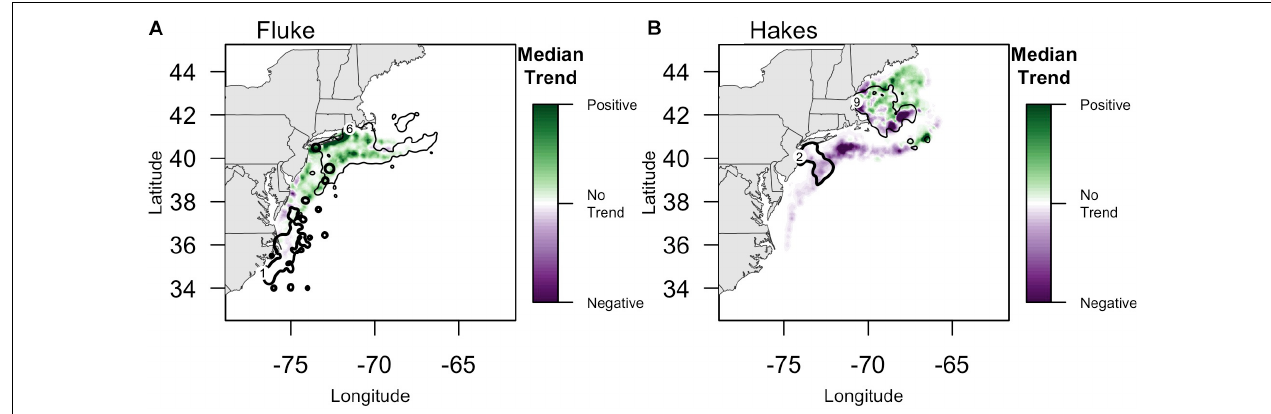
FIGURE 4 | Median Trend in NOAA survey biomass for (A) fluke and (B) red/silver hake (1976–2015). Purple colors indicate declining Median Trends in biomass, while green indicate increasing Median Trends in biomass, over this 40-year time span. Locations of focal ports where biomass trends are specifically highlighted in the text (numbers following Figure 2 ): (A) For fluke: 1: Beaufort, North Carolina; 6: Point Judith, Rhode Island;. For fluke, the 90% PVC for large trawlers in Beaufort, NC (bold line), and Point Judith, RI (thin line) is overlaid on the median trend. (B) For hakes: 2: Point Pleasant, New Jersey; 9: Gloucester, Massachusetts. For hakes, the 90% PVC for large trawlers in Point Pleasant, NJ (bold line), and Gloucester, MA (thin line) are overlaid on the median trend.